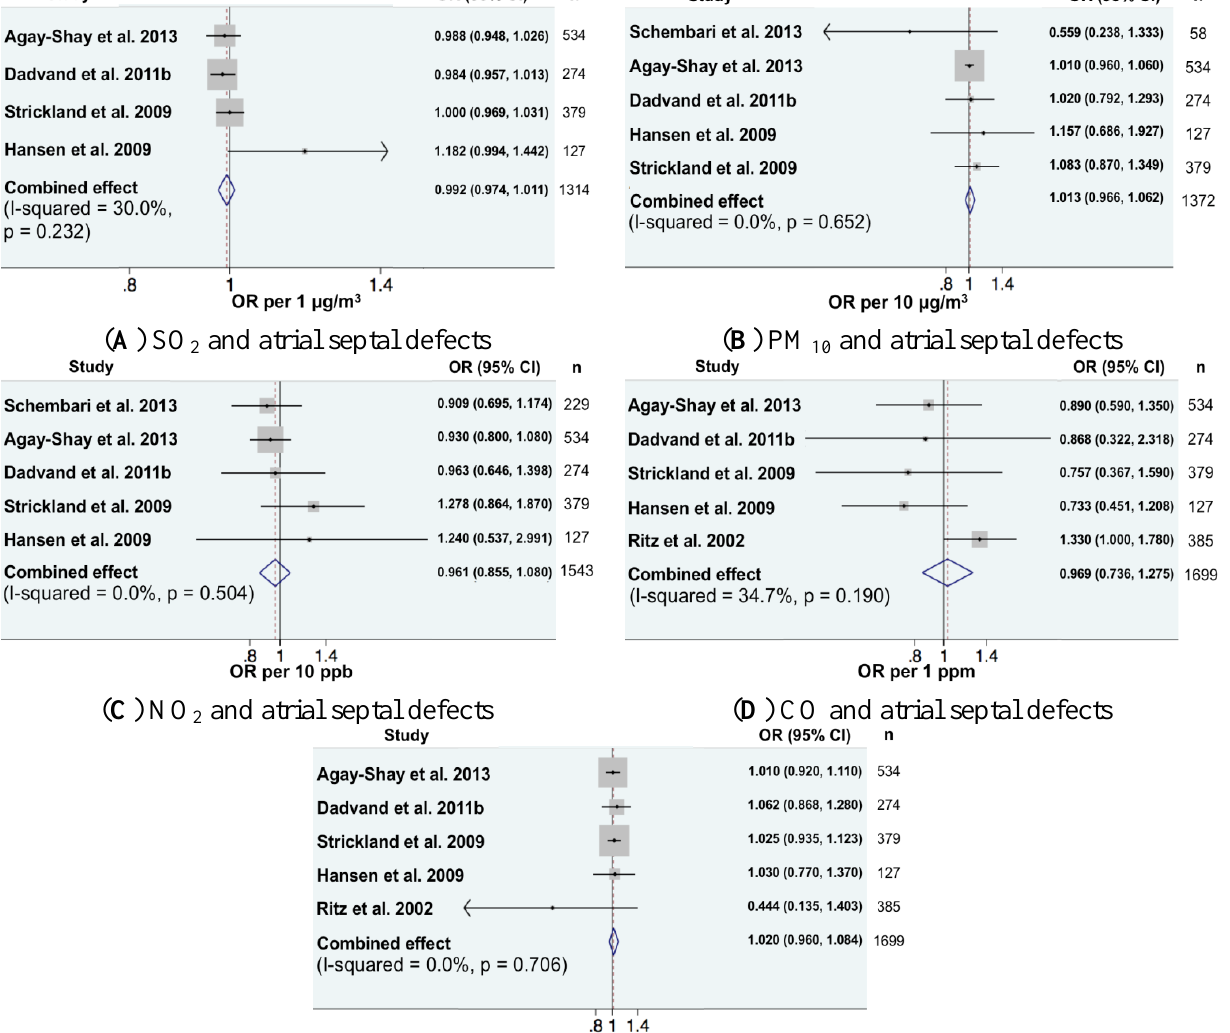
Figure 2. Forest plots for combinations of atrial septal defects and pollutant (as a continuous variable). The size of each square represents the weight that contributes to the combined effect, respectively for: ( A ) SO